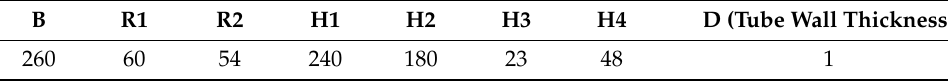
Figure 7. Hardware configuration of experimental platform. Table 3. Geometric parameters of measuring tube (mm).